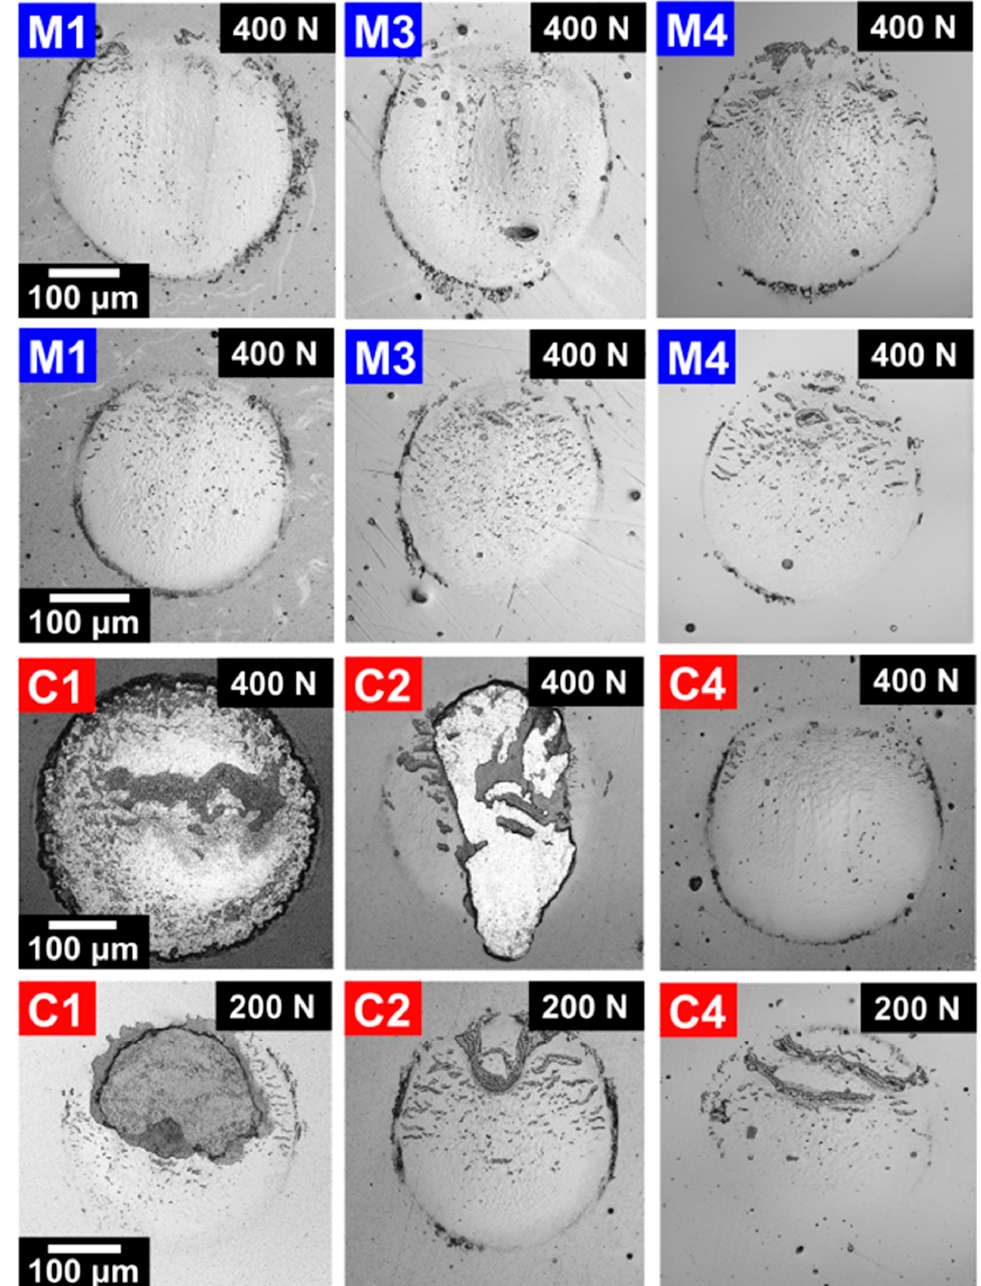
Figure 5. Optical micrographs of residual impact imprints at various impact loads for selected AlCrN coatings after 10 5 load cycles. coatings after 10 5 load